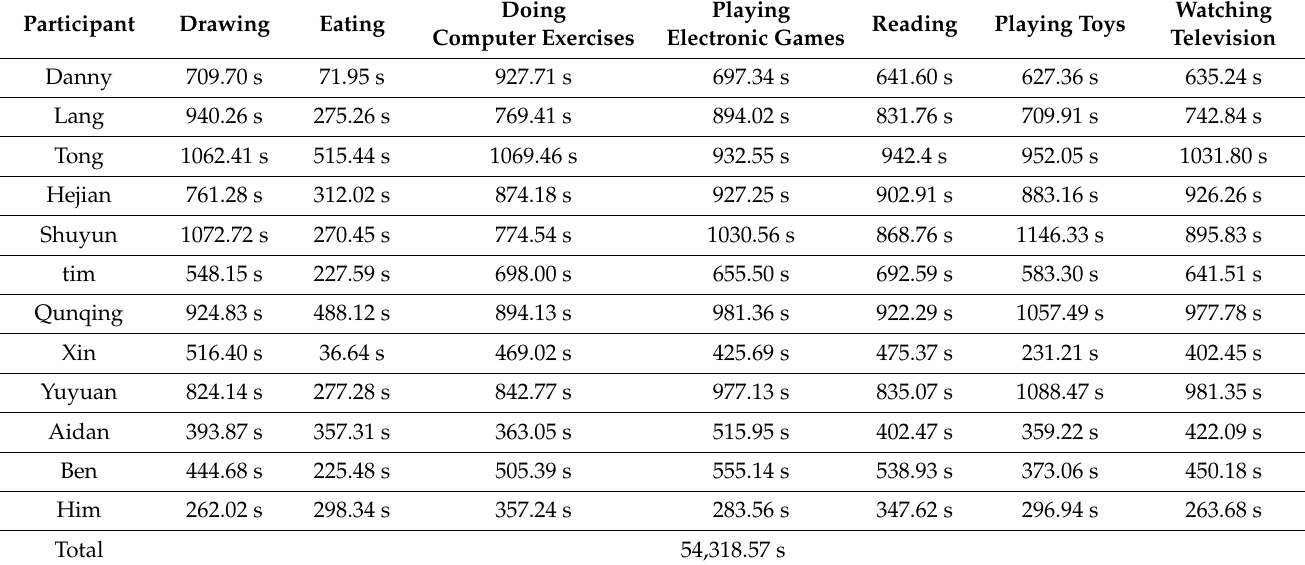
Figure 12. The average percentages of the classification accuracies over both these 12 participants performing the various activities yielded by both our proposed method and the traditional methods with different classifiers under the immersion state. Table 10. The total times required for performing the attention assessments for each individual for performing each activity under both the concentration state and the immersion state via the traditional methods with all three